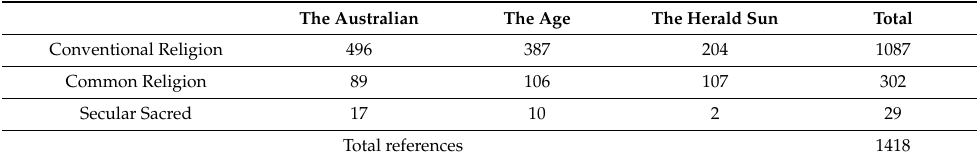
Table 1. Number of references coded in each